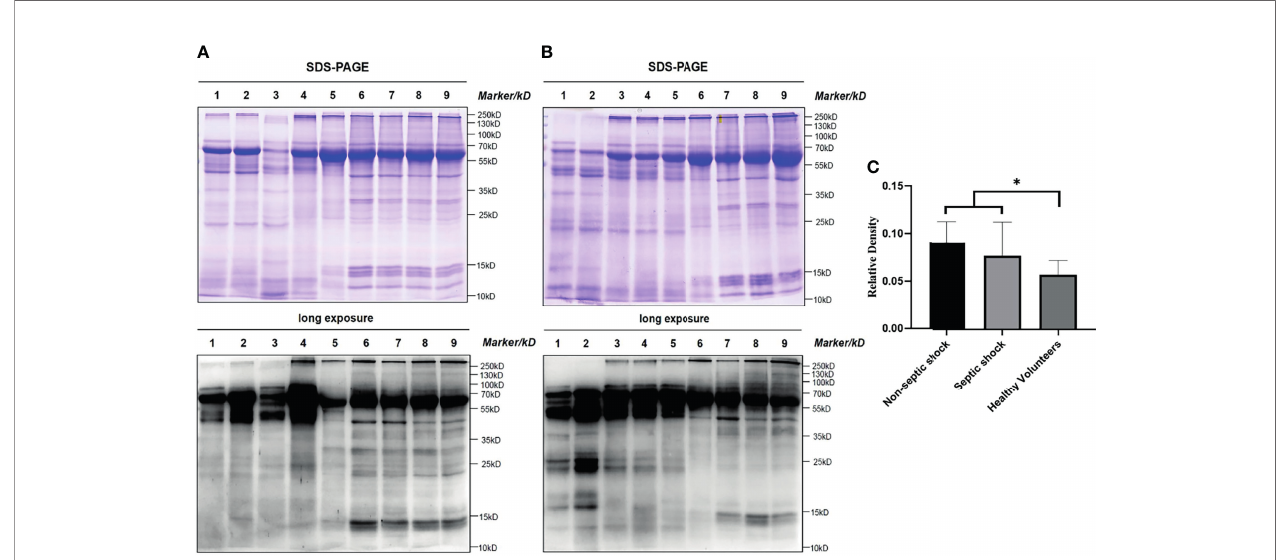
FIGURE 1 | All protein lactyl-lysine lactylation in different groups. Lactylation is an all-protein-posttranslational modi fi cation found in both healthy and shock patients. The difference was signi fi cant between shock patients and healthy volunteers (Students ’ t = 2.172, P =0.045). (A) and (B) : Bands 1-2: non-septic shock patients; bands 3-5: septic shock patients; bands 6-9: healthy volunteers; (C) : Relative density: (lane greyscale value of the anti-lactyl-lysine antibody)/(lane greyscale of SDS – PAGE × 15 m g). *P <